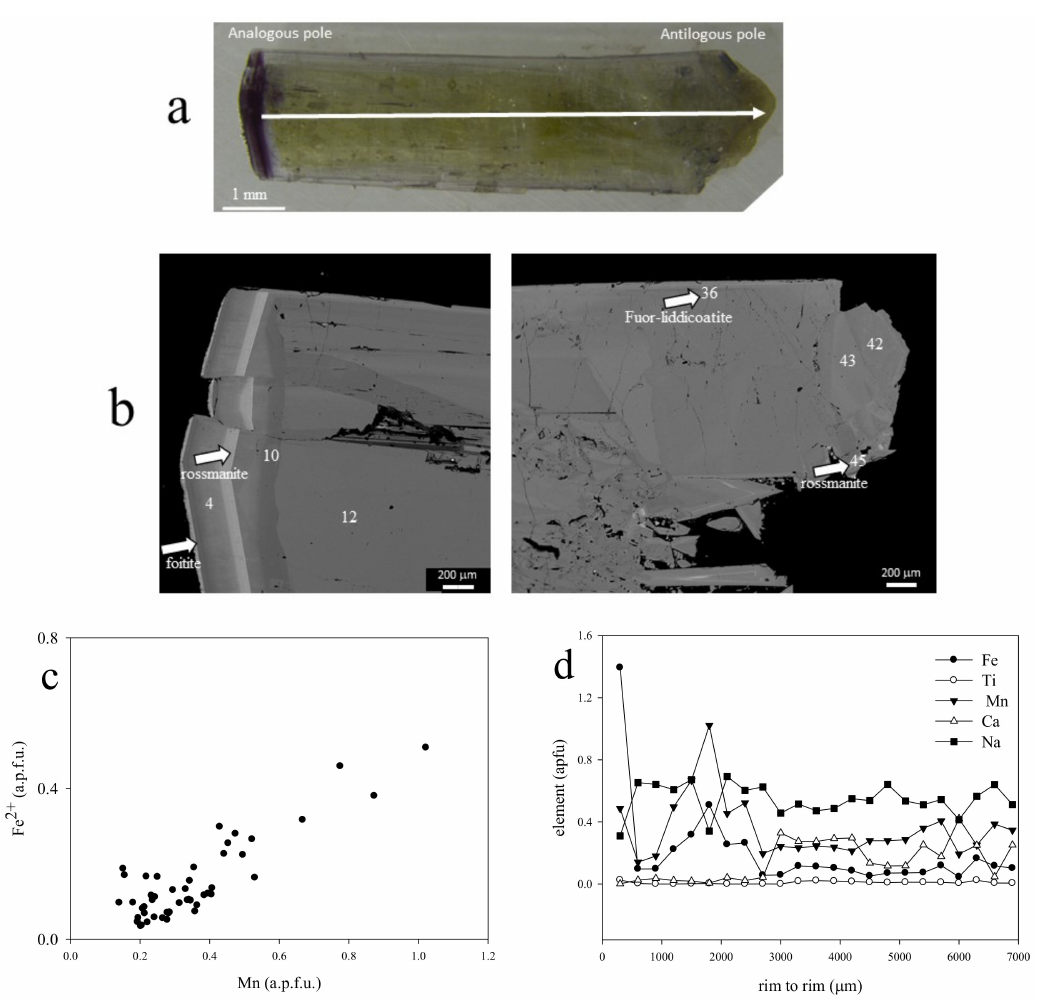
Figure 6. Optical microscope ( a ), BKSE ( b ) images, ( c ) variation of Fe vs. Mn and ( d ) an example of zoning patterns of different elements of sample 10. The points in BKSE images correspond to the points reported in Table